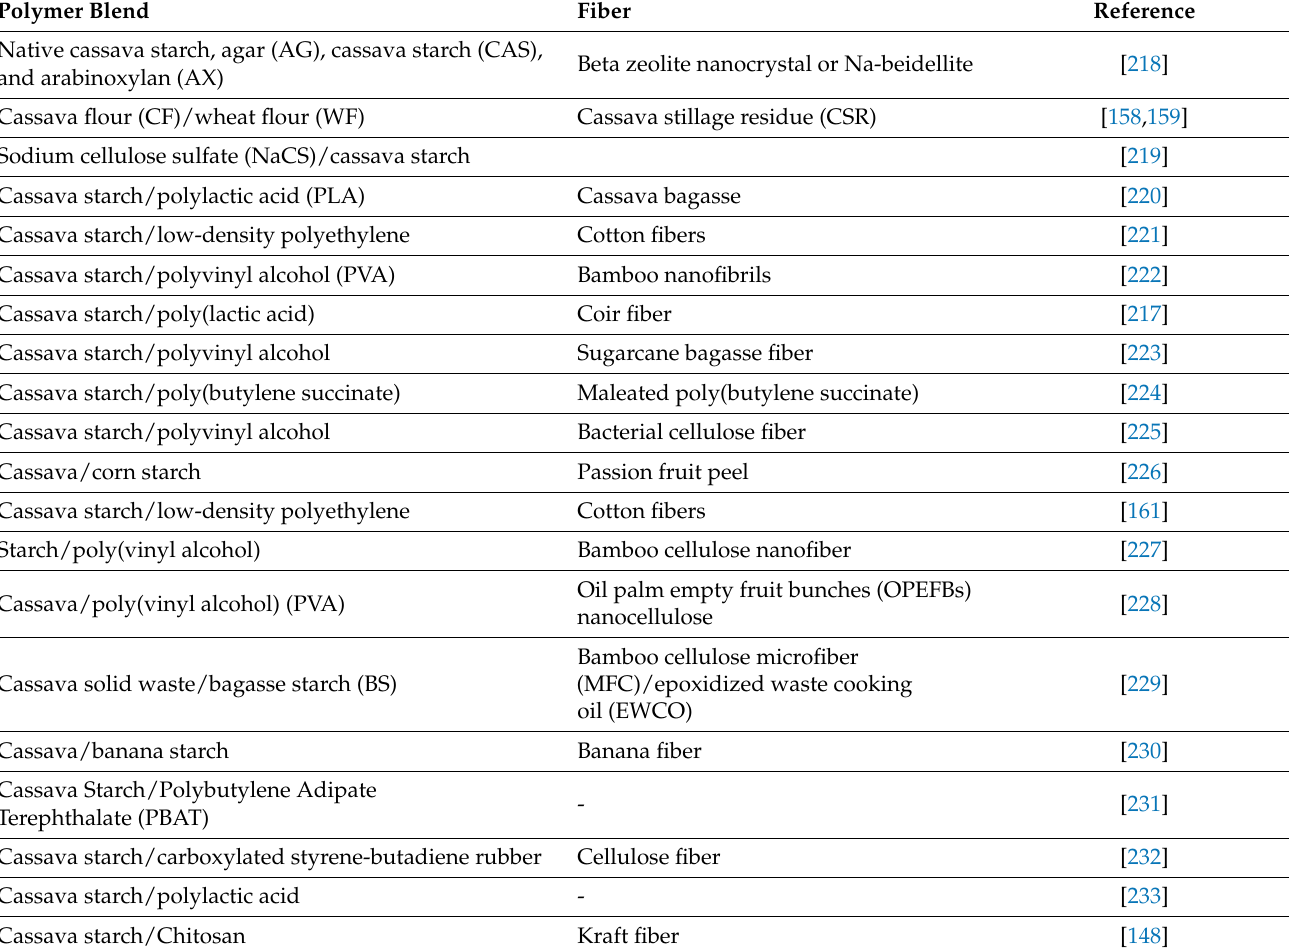
Table 7. Reported work on cassava starch-reinforced natural fibers polymer